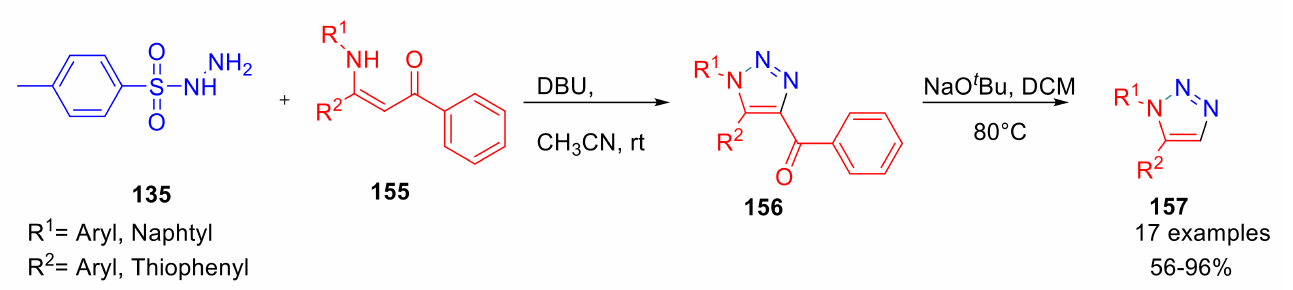
Scheme 50. Regiospecific synthesis of 1,5-disubstituted 1,2,3-triazoles 157 through C-C bond cleavage on 1,4,5-trisubstituted 1,2,3-triazoles 156